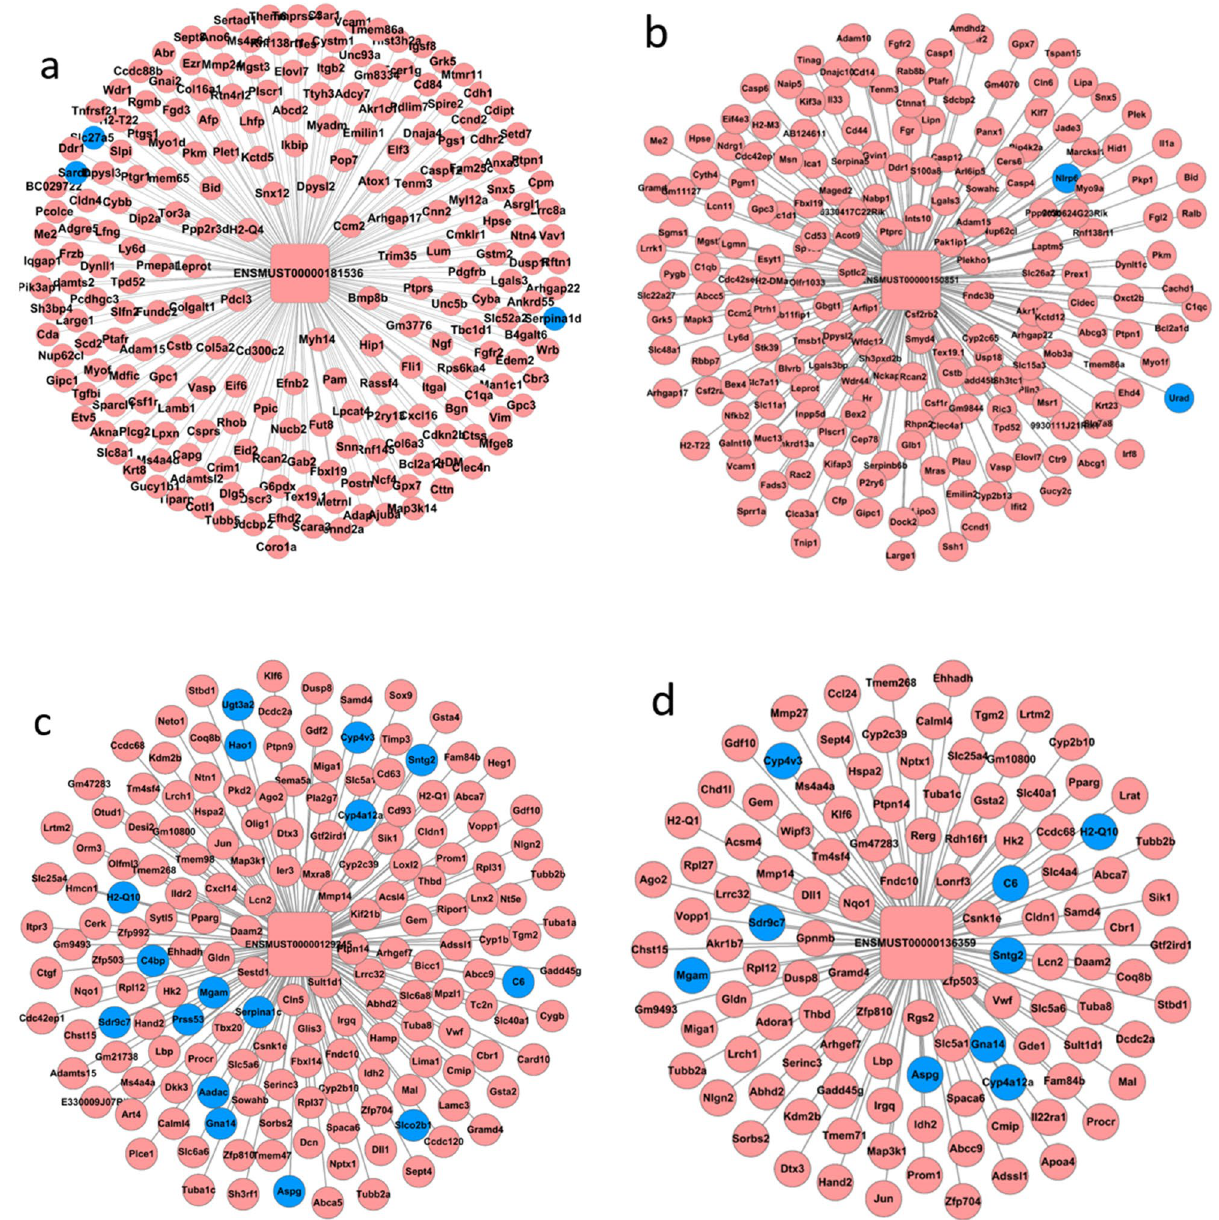
Figure 5. As shown in ( a ), ENSMUST00000181536 (Snhg19) correlated with 222 protein-coding genes, and the enrichment analysis showed that Snhg18 may be related to leukocyte transendothelial migration, phagosome, glutathione metabolism, regulation of actin cytoskeleton, natural killer cell mediated cytotoxicity, focal adhesion, Fc epsilon RI signalling pathway, cell adhesion molecules, apoptosis, and Fc gamma R-mediated phagocytosis. As shown in ( b ), ENSMUST00000150851 (Meg3) correlated with 200 protein- coding genes, and KEGG enrichment analysis pointed out that it may participate in sphingolipid metabolism, regulation of actin cytoskeleton, glycosaminoglycan degradation, complement and coagulation cascades, adherens junction, leukocyte transendothelial migration, galactose metabolism, haematopoietic cell lineage, chemokine signalling pathway, p53 signalling pathway, B cell receptor signalling pathway, Fc epsilon RI signalling pathway, ABC transporters, mitogenactivated protein kinase (MAPK) signalling pathway, and apoptosis. As shown in ( c ), ENSMUST00000129245 (Meg3) correlated with 169 protein-coding genes, that enriched to dozens of KEGG pathway, such as gap junction, ABC transporters, peroxisome, glutathione metabolism, GnRH signalling pathway, complement and coagulation cascades, peroxisome proliferator-activated receptor (PPAR) signalling pathway, metabolism of xenobiotics by cytochrome P450, phagosome, tryptophan metabolism, fatty acid degradation, carbohydrate digestion and absorption, Notch signalling pathway, ribosome, and toll-like receptor signalling pathway. KEGG analysis revealed that two lncRNA transcripts were both related to ABC transporters and complement and coagulation cascades, although these two transcripts did not share the same gene of interaction. As shown in ( d ), ENSMUST00000136359 (H19) correlated with 169 protein-coding genes, including vitamin digestion and absorption, galactose metabolism, carbohydrate digestion and absorption, retinol metabolism, phagosome, gap junction, arachidonic acid metabolism, butanoate metabolism, complement and coagulation cascades, antigen processing and presentation, PPAR signalling pathway, ABC transporters, Notch signalling pathway, bile secretion, and MAPK signalling